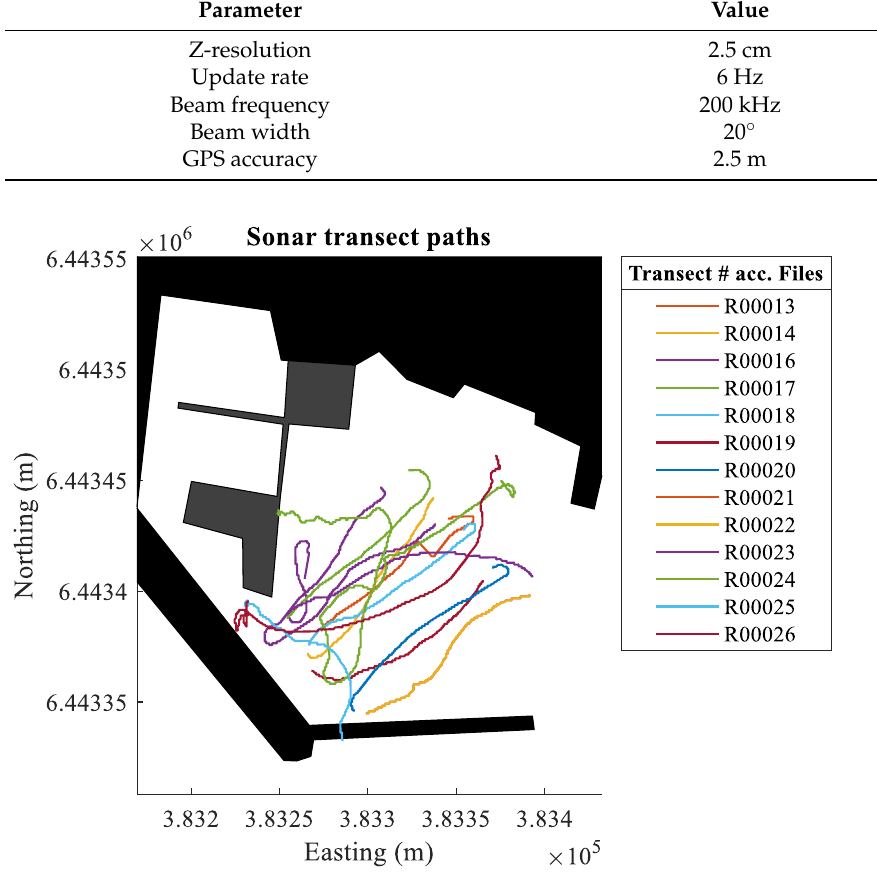
Figure 6. Paths of the skiff during the sonar survey transects; transect identifications according to file names.